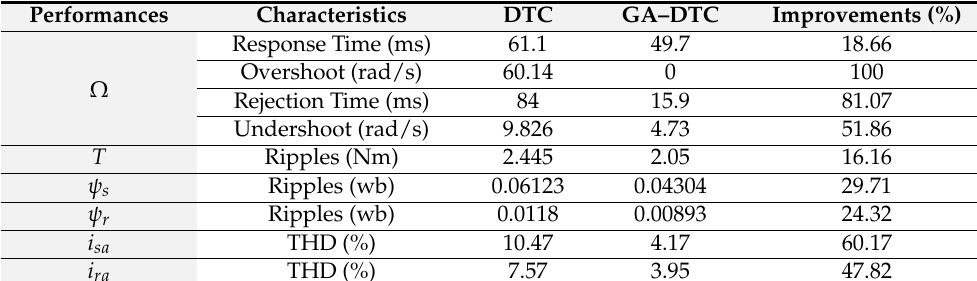
Table 4. Performance measures of classic DTC and GA–DTC.